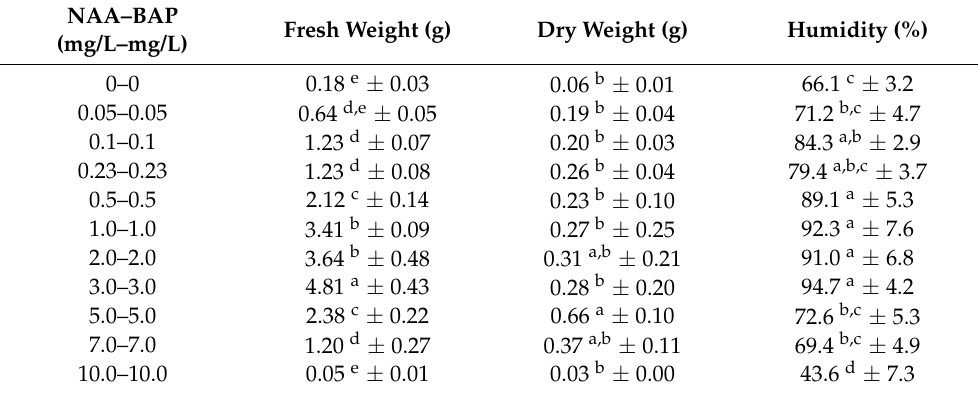
Table 8. Fresh weight, dry weight, and humidity content of T. officinale callus derived from hypocotyls maintained under different NAA/BAP combinations (medium MS supplemented with sucrose 2.3%, at 18 ± 2 ◦ C, 0/24 h light/dark, and 4 months after induction).